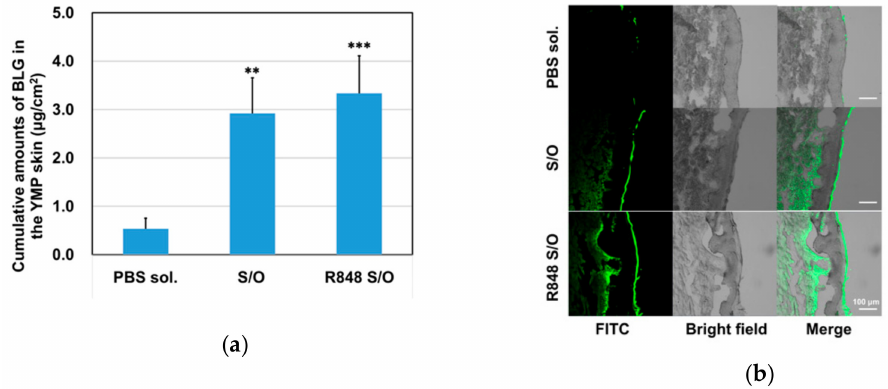
Figure 2. In vitro skin permeation in Yucatan micropig (YMP) skin. ( a ) Cumulative amounts of Fluoroscein 5-isothiocyanate (FITC)-labelled BLG in the solid-in-oil nanodispersion (S / O) and the S / O with R-848 (R-848 S / O) that permeated through the YMP skin after 24 h of incubation. * p < 0.05, ** p < 0.01, *** p < 0.001 compared with the PBS solution (PBS sol.).; ( b ) Representative fluorescent microscopy images of the YMP skin sections after 24 h of BLG administration.